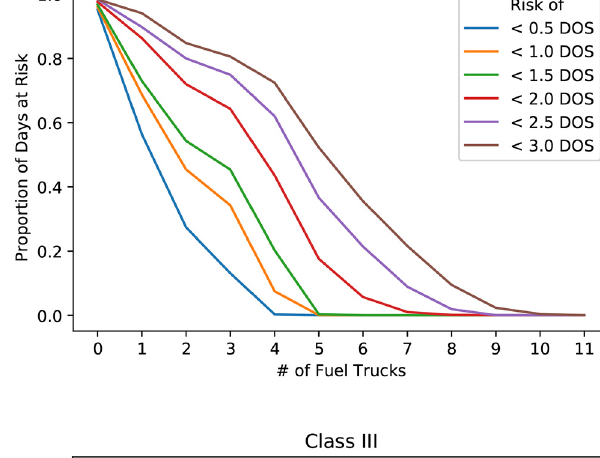
Figure 6. Expected value